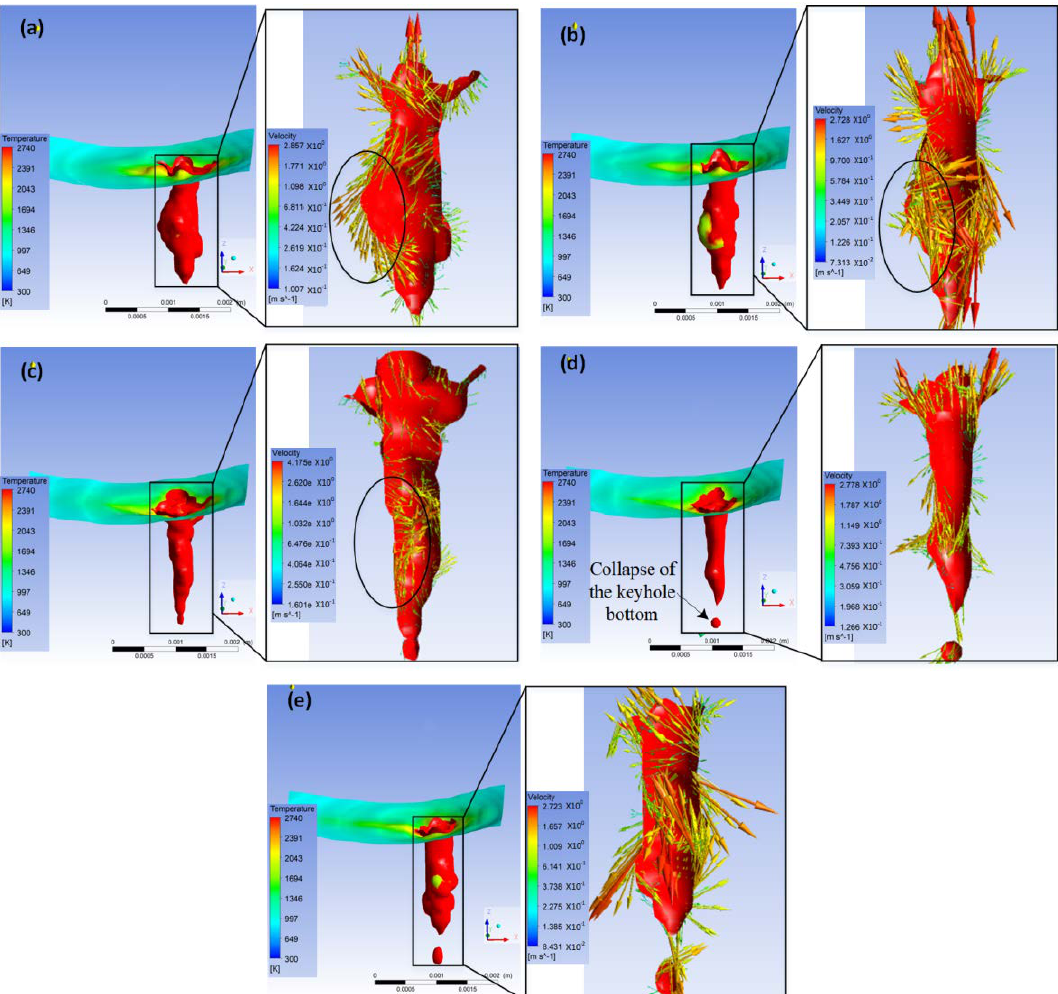
Figure 5. The dynamic fluctuation of keyhole wall and the melt flow on keyhole wall with preheating temperature of 400 K: ( a ) t = 26.4 ms, ( b ) t = 26.5 ms, ( c ) t = 26.7 ms, ( d ) t = 26.8 ms, ( e ) t = 29 ms.